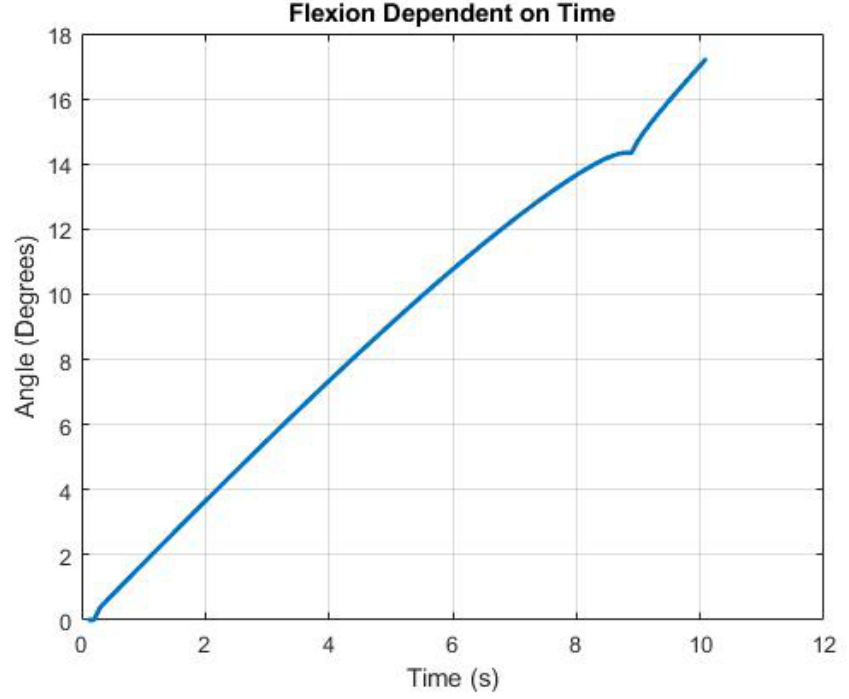
Figure 9. Change in angle per chamber through constant air